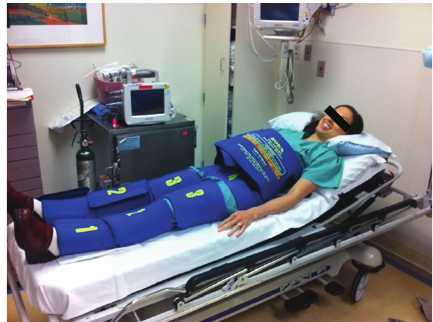
Figure 1: Nonpneumatic antishock garment worn in demonstration by the author